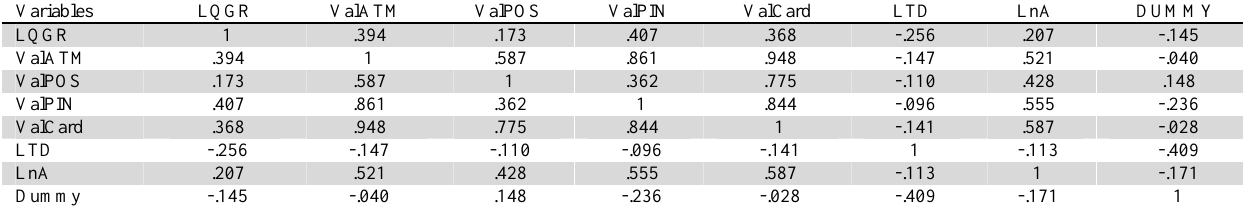
Relationship between dependent and independent variables in the second